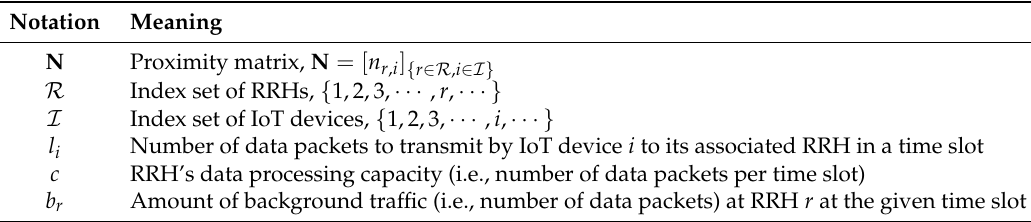
Table 2. Summary of